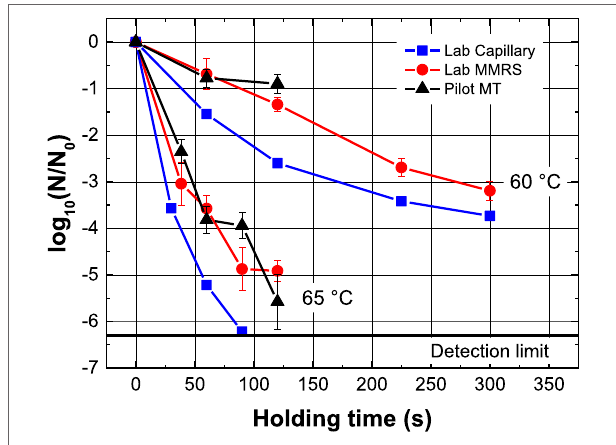
FiGUre 2 | Scale-up case study, inactivation of thermal indicator ( Lactobacillus mixture in phosphate buffered saline, pH 7.2) during different processes and scales; batch glass capillary of 60 µl ( ■ ), continuous modular micro reaction system with a max of 1 kg h − 1 ( ● ), and a continuous pilot scale (MT) with a max of 75 kg h − 1 ( ▲ )